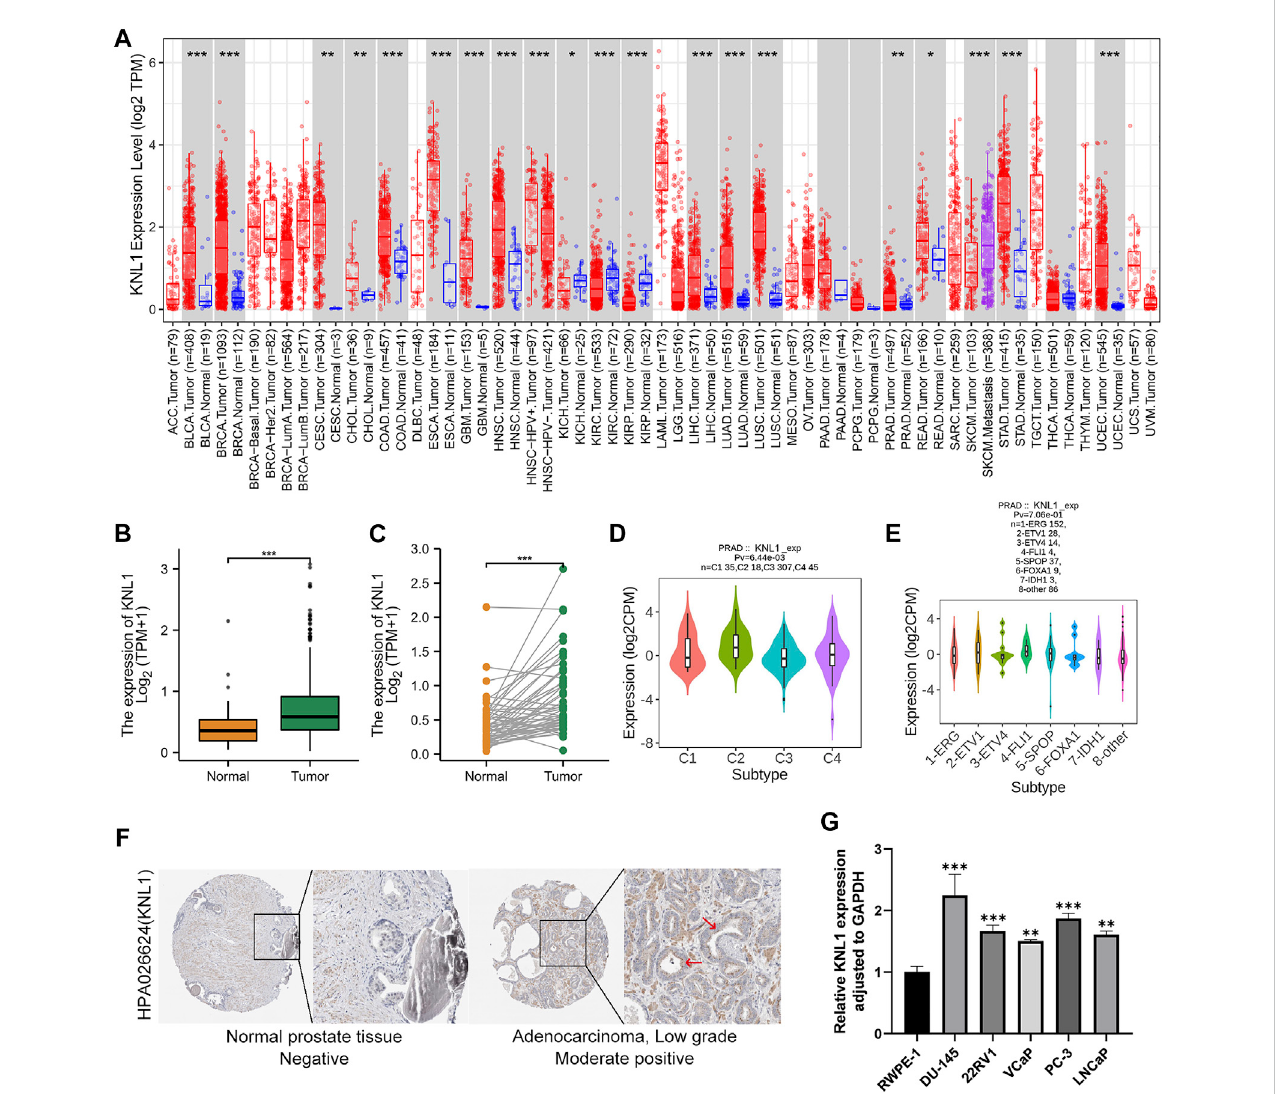
FIGURE 1 KNL1 expression levels in human cancers. (A) KNL1 mRNA levels in different tumor types from TCGA database were determined by TIMER. (B) KNL1 is expressed at higher levels in PRAD than in non-cancerous adjacent tissues. (C) mRNA expression levels of DRP1 in matched PRAD and adjacent non- cancerous samples in the TCGA database were compared. (D) Correlations between KNL1 expression and molecular subtypes in PRAD. (E) Correlations between KNL1 expression and immune subtypes in PRAD. (F) KNL1 protein levels in normal prostate and PRAD were visualized using immunohistochemistry via HPA.(* p < .05,** p < .01,*** p < .001). (G) qRT-PCRanalysisofKNL1expressioninnormalhumanprostatecellline(RWPE-1)and fi ve prostate cancer cell lines (DU-145, 22RV1, VCaP, PC-3, LNCaP). * p < .05, ** p < .01, *** p <